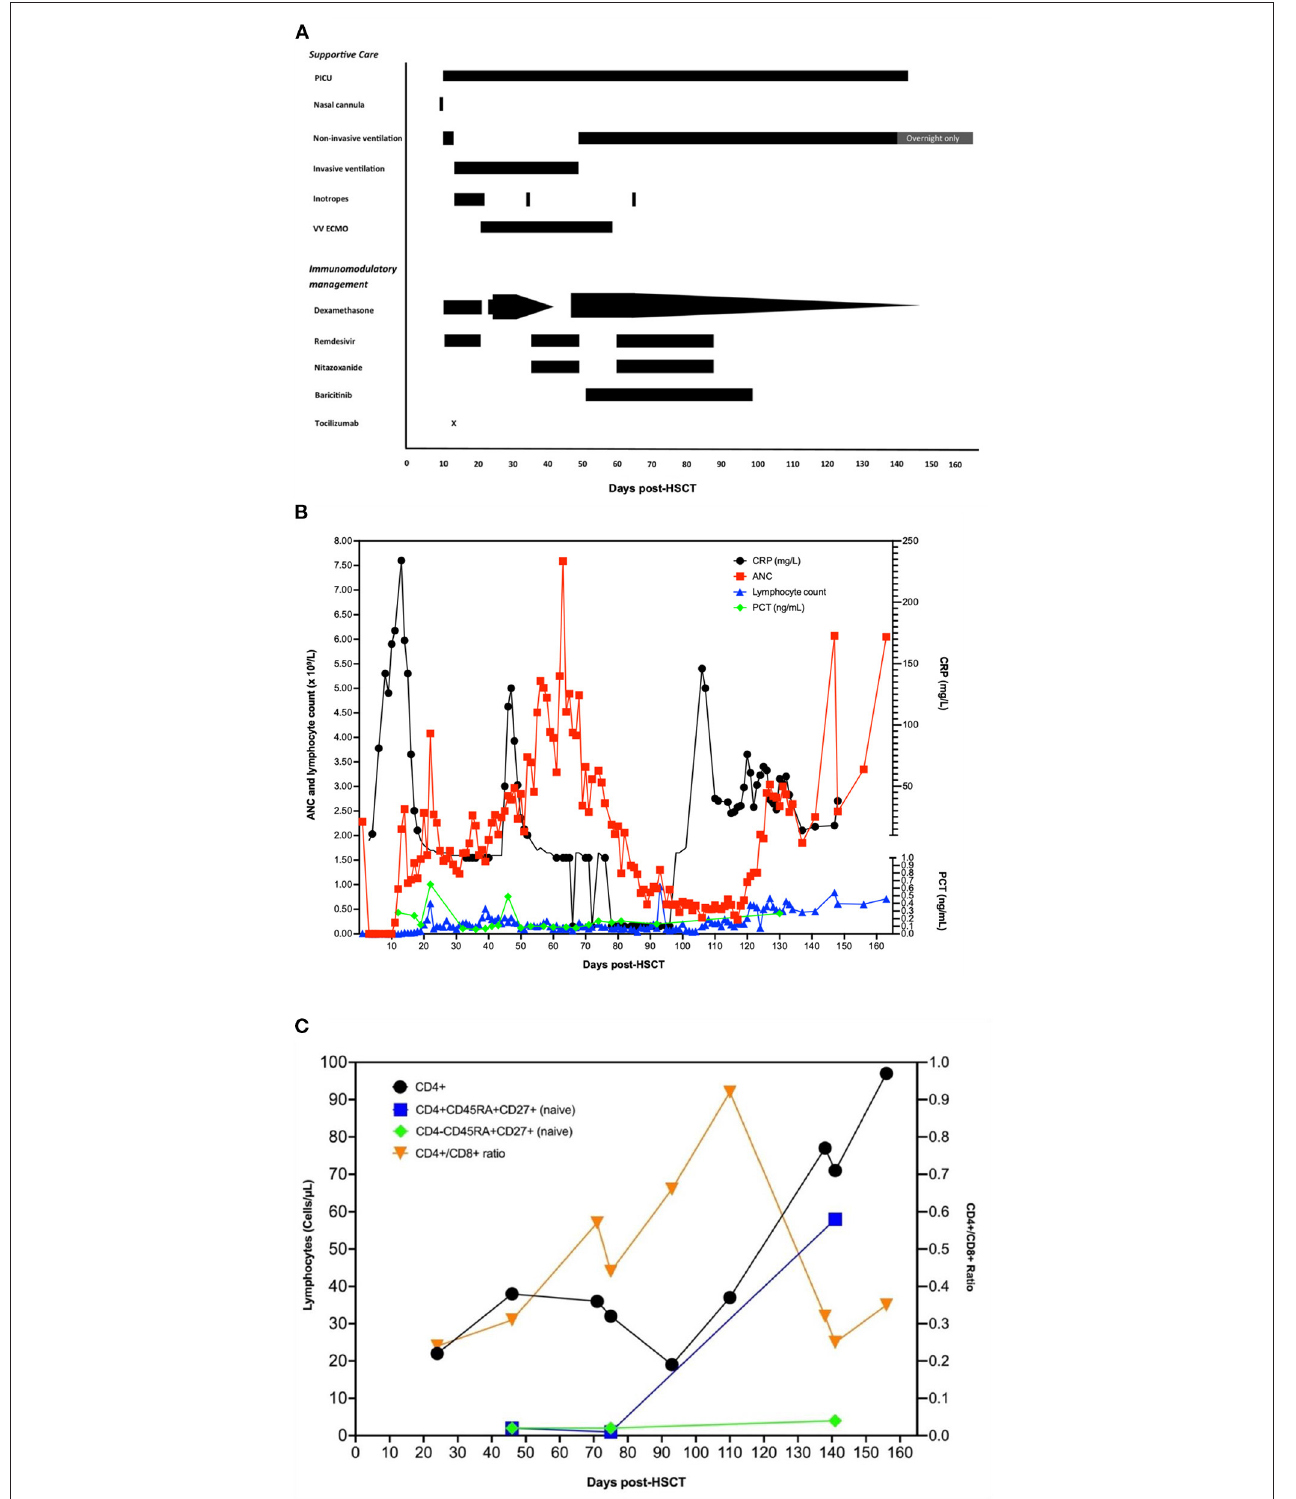
FIGURE 1 | A schematic overview of respiratory and immunomodulatory management over time. (A) Overview of respiratory support and medical interventions over time. Day 0 is the day of autologous stem cell infusion and the day the patient first tested positive for SARS-CoV-2. (B) Overview of inflammatory markers and neutrophil and lymphocyte counts over time. Day 0 is the day of autologous stem cell infusion. ETT/BAL, endotracheal/bronchoalveolar lavage secretions; NTS, nose–throat swab; ANC, absolute neutrophil count; CRP, C-reactive protein; PCT, procalcitonin. (C) CD4 lymphocytes and naïve T-cell counts over time. Day 0 is the day of autologous stem cell